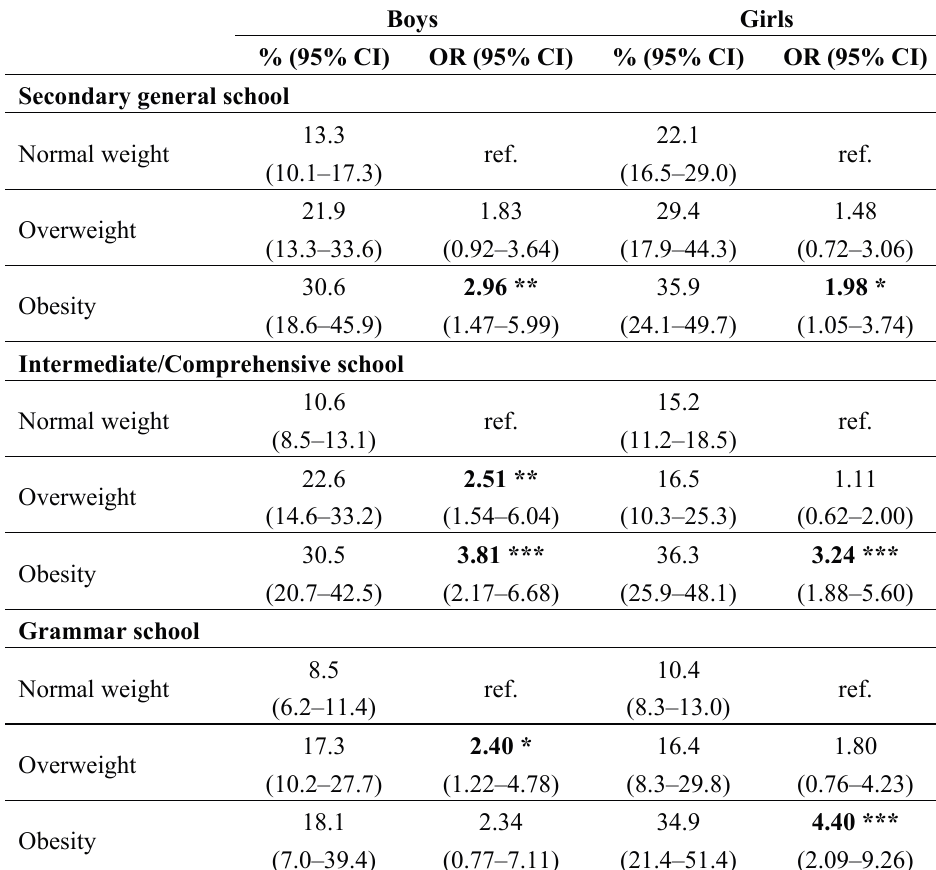
Table 4. Relation between BMI and SRH (fair to very poor) among adolescents aged 11 to 17 years stratified by type of school (n = 4831). Prevalence and age-adjusted odds ratios (OR) with 95% confidence intervals (95% CI).